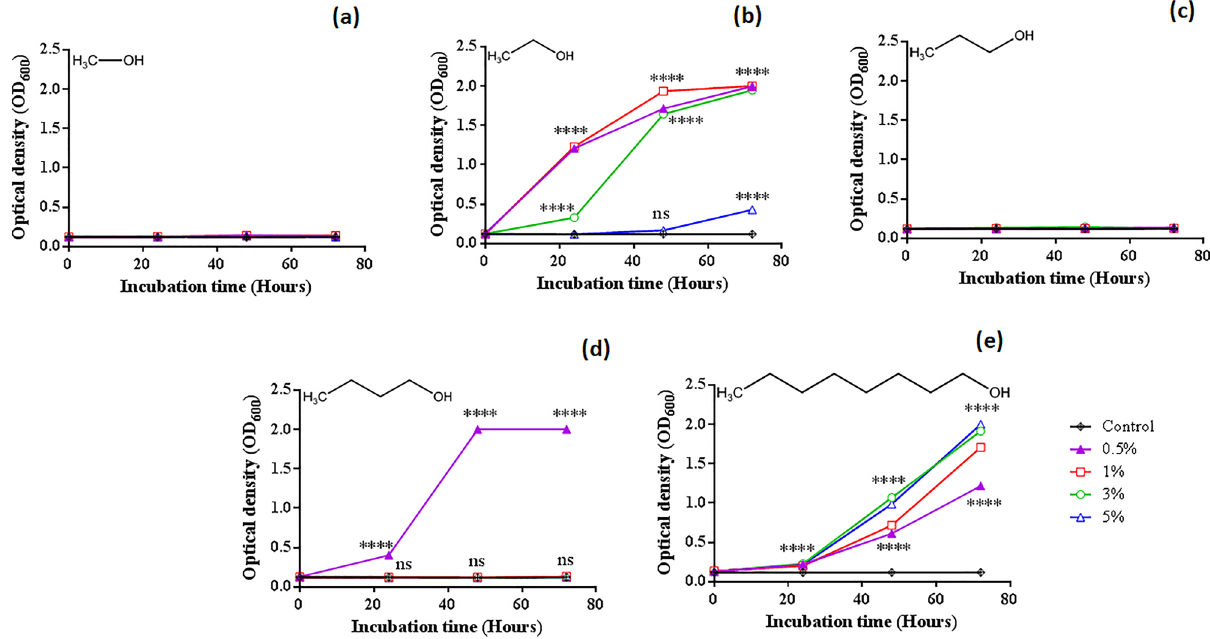
Figure 1. Growth kinetics of Pseudomonas sp. NEEL19 under the direct contact of 0.5 ‒ 5% (v/v) alcohols when supplied as sole energy and carbon sources in DSMZ 125*. Growth pattern in ( a ) methanol, ( b ) ethanol, ( c ) 1-propanol, ( d ) 1-butanol and (e ) 1-octanol are shown. Inoculated DSMZ 125* without respective carbon source was used as a control. OD 600 , optical density at 600 nm. Error bar, mean (n = 3) ± s.d., are smaller than symbols. **** P < 0.0001; ns, non-significant. Dose: Open-diamond, control (0%); filled-triangle, 0.5%; open- square, 1%; open-circle, 3%; open-triangle,